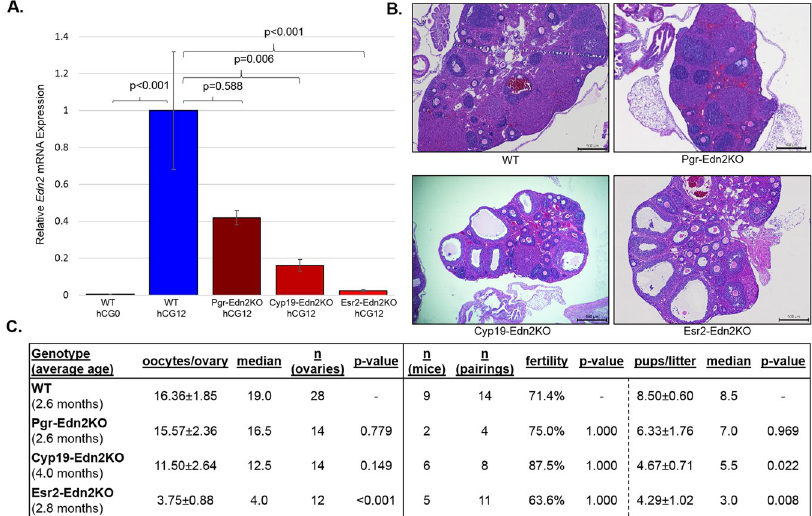
Figure 3. Loss of EDN2 reduces oocytes ovulated and decreases average litter size. Edn2flox mice were crossed with Pgr-Cre, Cyp19-iCre, and Esr2-iCre mice to remove Edn2 expression in granulosa cells. ( A ) Relative Edn2 mRNA expression in whole ovaries compared to WT hCG12 ovaries. Expression of Edn2 is significantly lower in WT mice at hCG0 and in Cyp19-Edn2KO and Esr2-Edn2KO mice at hCG12 hours. ( B ) Representative histological images from ovaries of each genotype at hCG24 hours (4X). Ovaries from each genotype appeared healthy and all had corpora lutea, antral follicles, and immature follicles with no difference in hemorrhage between groups. Note the multiple antral follicles with trapped oocytes present in Cyp19-Edn2KO and Esr2- Edn2KO mouse lines. ( C ) Breeding study and superovulation oocyte collection results. Each pairing lasted 10 days; litter size represents pups present on day of birth; oocytes were collected from the ampulla of the oviduct at hCG24 hours. P-values are from the post hoc test relative to control mice. All error bars represent the